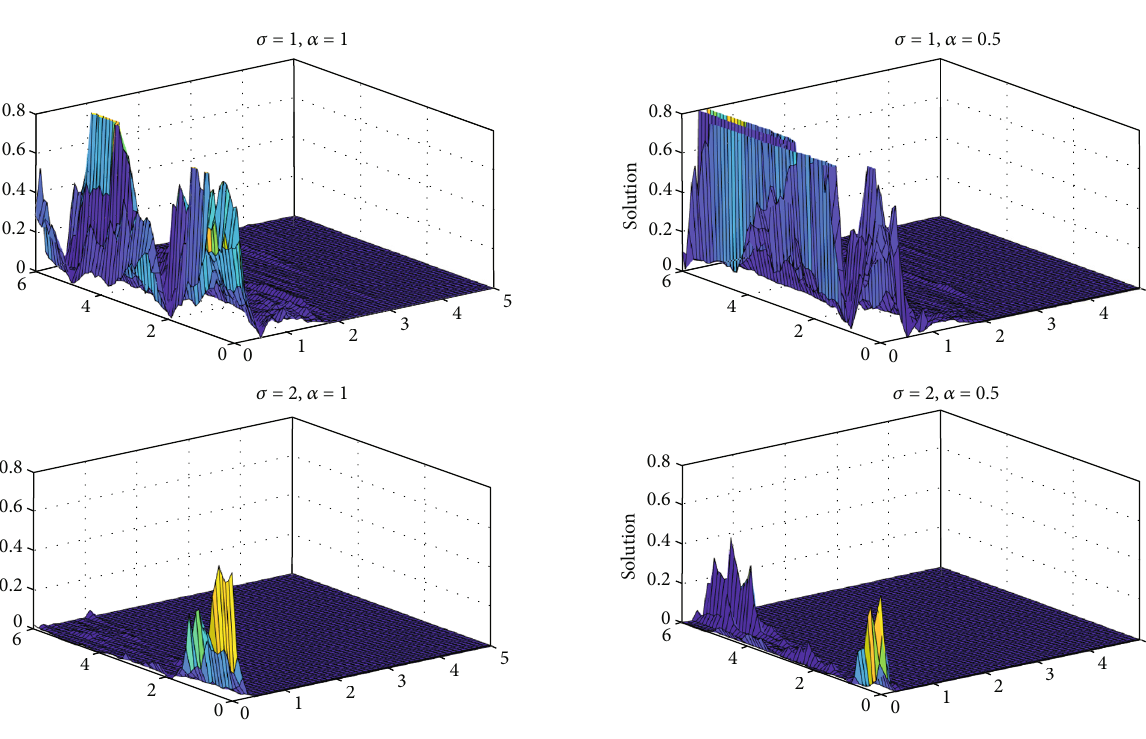
Figure 2: 3D diagrams of Equation (41) with α = 1 : Figure 3: 3D diagrams of Equation (41) with α = 0 : 5 .